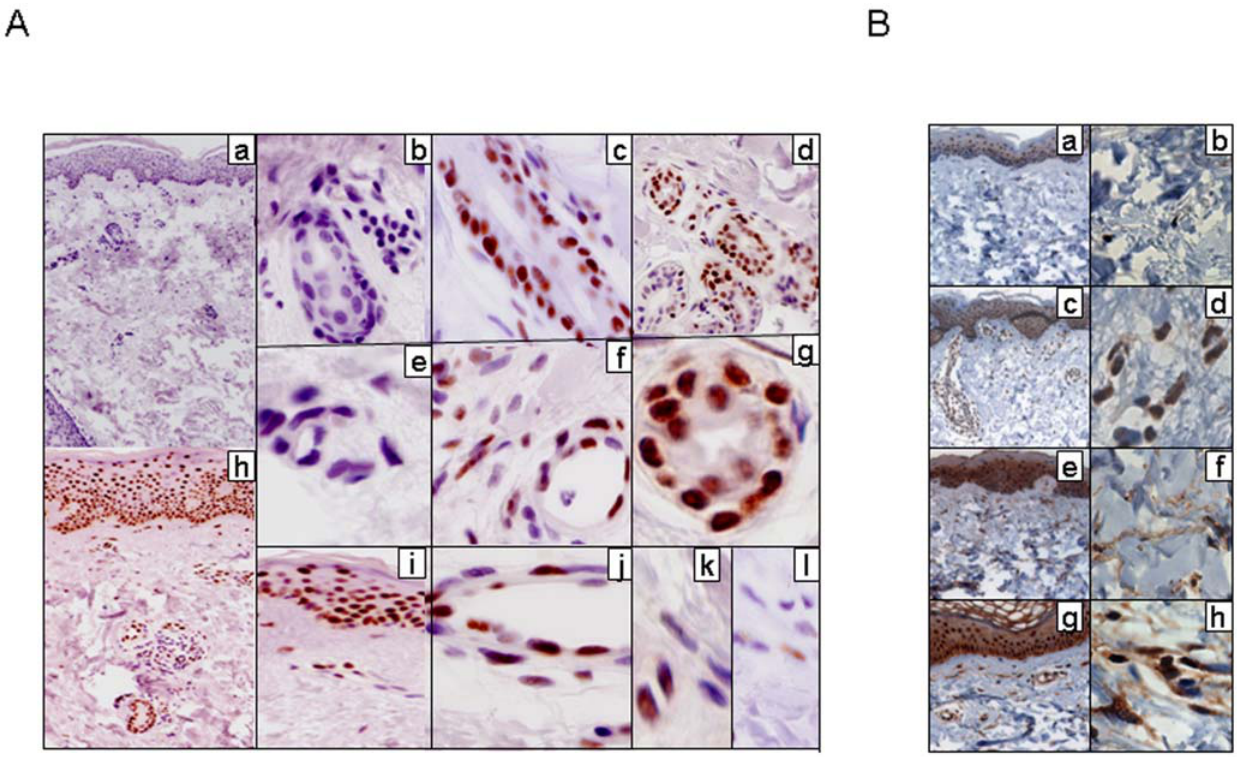
Figure 7. Elevated Nab2 expression in scleroderma skin biopsies. Lesional skin biopsies were obtained from patients with scleroderma (n=6) and healthy controls (n=3), and processed for immunohistochemistry as described under Methods. A. Nab2 expression. Skin biopsies from healthy controls (a, b, e) and scleroderma patients (c, d, f, g, h–l). Original magnification 6 100(a, h), 6 400 (b, d, i), 6 630 (c, e, f, j, k, l). Note uniformly intense Nab2 nuclear immunoreactivity in epithelial cells in scleroderma skin biopsies (h, i, l), as well as in perifollicular and periglandular (c, d, g) epithelial cells and vascular endothelial cells (f, j), compared to weak and variable Nab2 expression seen in occasional dermal fibroblasts (k, l). Representative photomicrographs; similar immunostaining pattern was observed in all six scleroderma skin biopsies. B . Phospho-Smad2 (a–d) or Egr- 1 (e–h) expression. Nuclei are counterstained with hematoxylin (blue). Note strong immunostaining in dermal fibroblasts in scleroderma (d, h) skin biopsies compared to healthy controls (b,